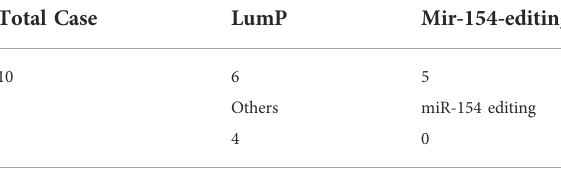
TABLE 3 miR-154 editing events in 10 cases that have mRNA-seq results; 5 of the 6 LumP cases have miR-154 editing